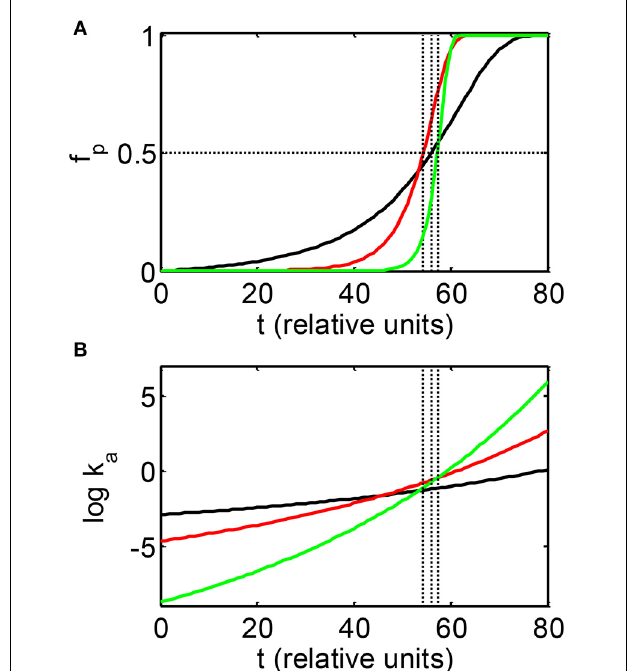
FIGURE 2 | Dependence of the mass fraction of polymer (A) and the logarithm of the association rate constant (B), calculated according to the condensation model as described in the text. Parameters associated with each simulation are presented in Table 2 . Vertical dotted lines indicate the values of t 50 associated with each simulation.